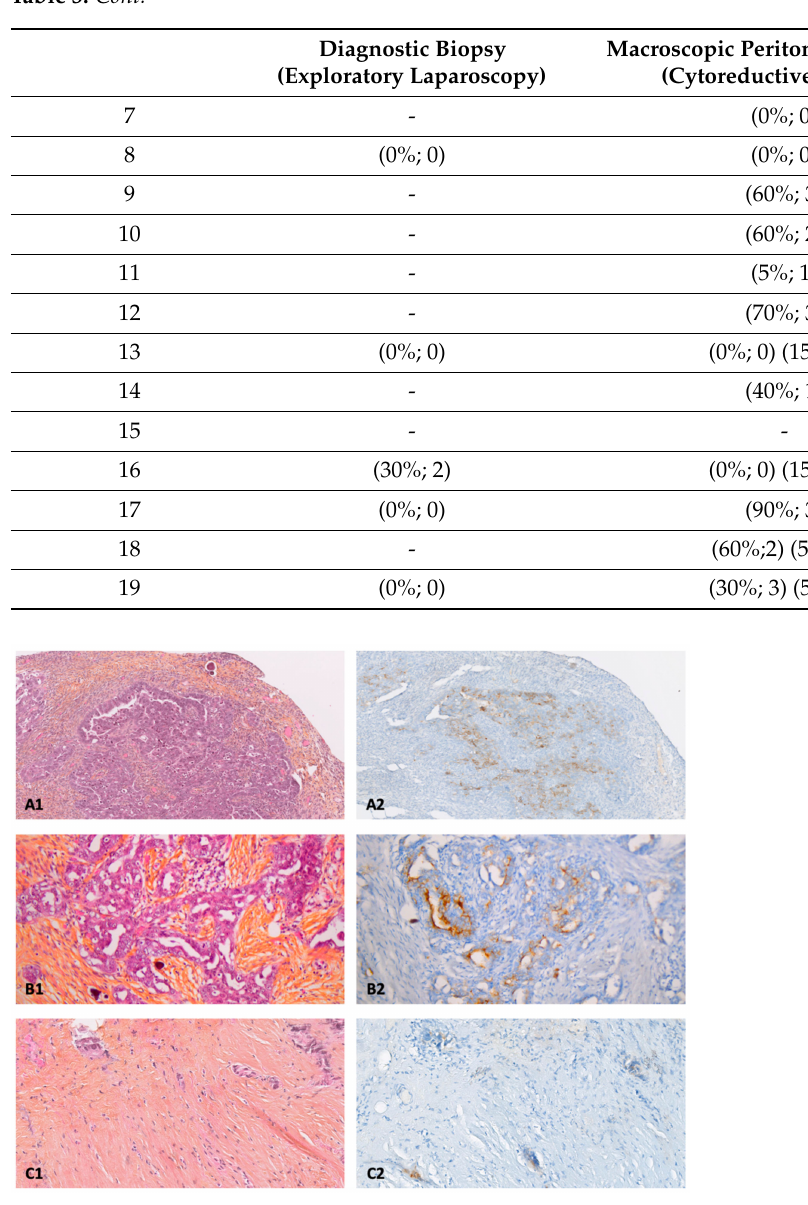
Figure 1. Anatomopathological examination of primary and peritoneal lesions of high-grade serous ovarian carcinoma (HES: Hematein, Eosin, Saffron), and expression of folate receptor alpha (FR α ) by immunohistochemistry. ( A1 ): primary cancer × 10/( A2 ): FR α (75%; 3), ( B1 ): macroscopic peritoneal metastase × 20/( B2 ): FR α (30%; 3), ( C1 ): microscopic peritoneal metastases × 10/( C2 ): FR α (30%; 2), FR α (percentage of FR α positive tumor cells; staining